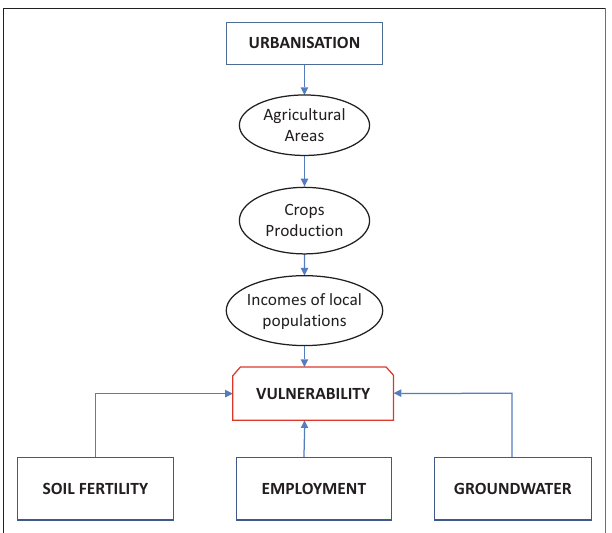
FIGURE 1: Conceptual model of analysis of the vulnerability in the Niayes region.